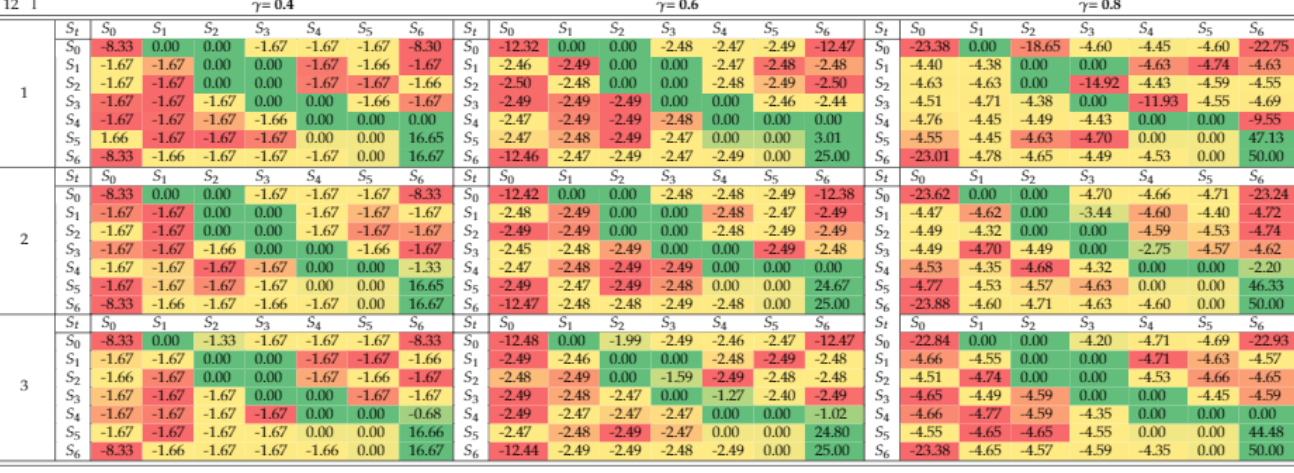
Figure 17. Q-matrix of each simulation of 3 different values of γ (0.4, 0.6, 0.8). The values of the Q-matrix correspond to the maximum rewards obtained from switching from state S t to state S t + 1